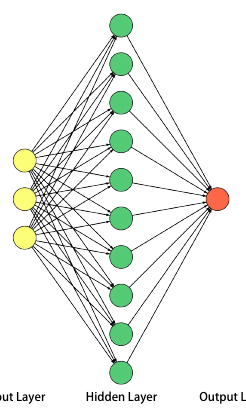
Figure 4 . Architecture of the selection neural